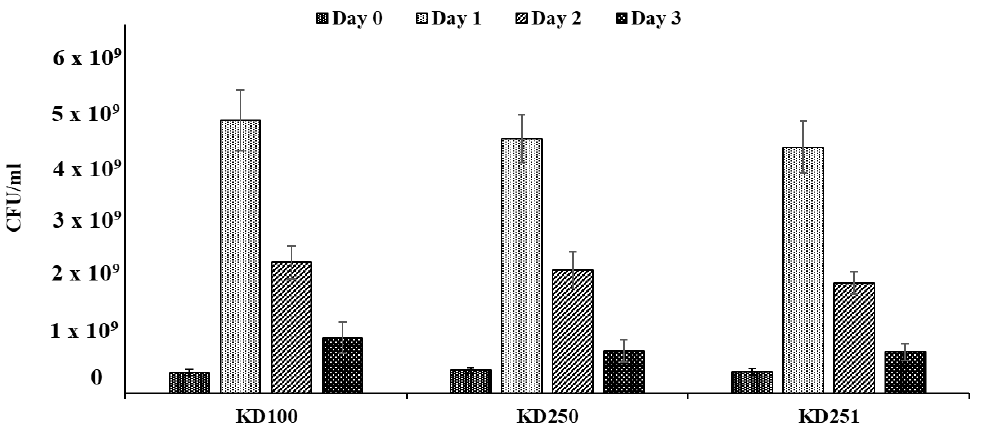
Figure 8. Survival capacity of P. carotovorum strains. Bacterial population was measured in celery petioles to determine the survival response in the host plant. Approximately 3.8 × 10 8 CFU/mL of bacterial suspension was used to inoculate celery petioles. Bacterial cell count was taken of infected celery on days 0, 1, 2, and 3 post inoculation. Values are the mean (from three replicates) ± standard deviation.